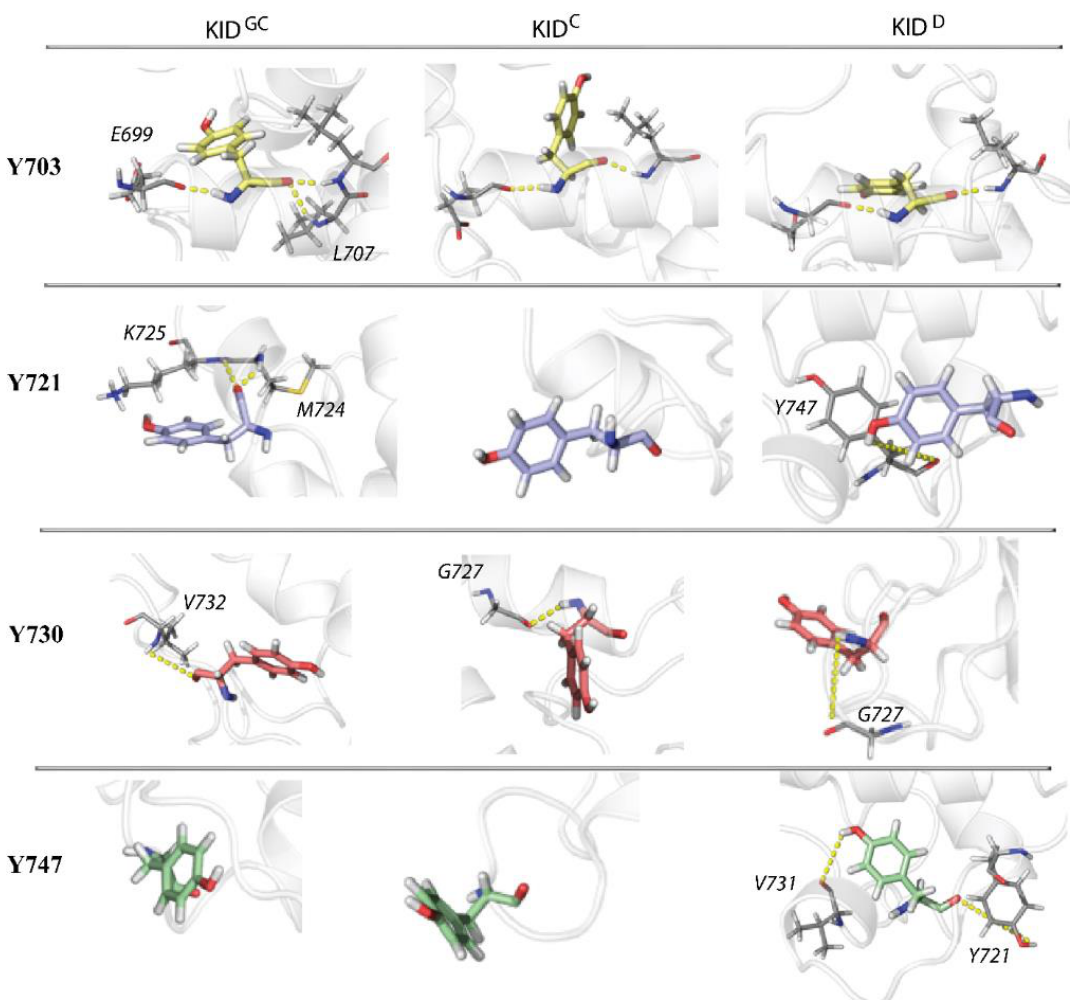
Figure 6. Snapshots of the KID fragments with tyrosine residues were taken at the top of each distribution (see Figure 3B). Oxygen and nitrogen atoms are in red and blue; respectively, carbon atoms are coloured differently for each tyrosine residue (Y703 in yellow, Y721 in lilac, Y730 in coral, and Y747 in green) and similarly (in grey) for other KID residues. Protein is shown as a grey cartoon. The yellow dashed lines represent the hydrogen bonds between atoms of the named residues.